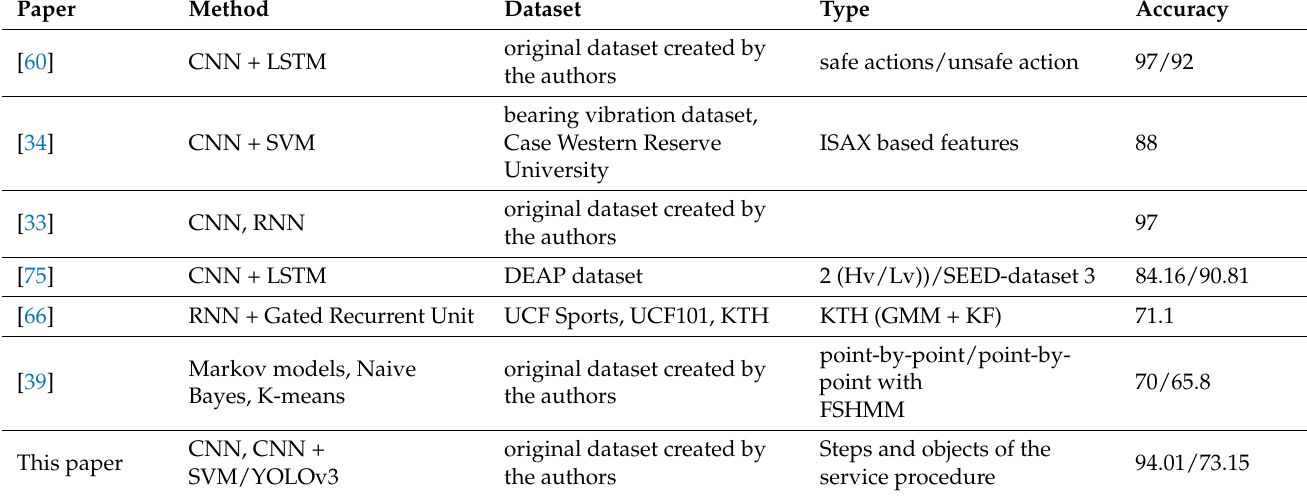
Table 1. Comparing the research results with state-of-the-art